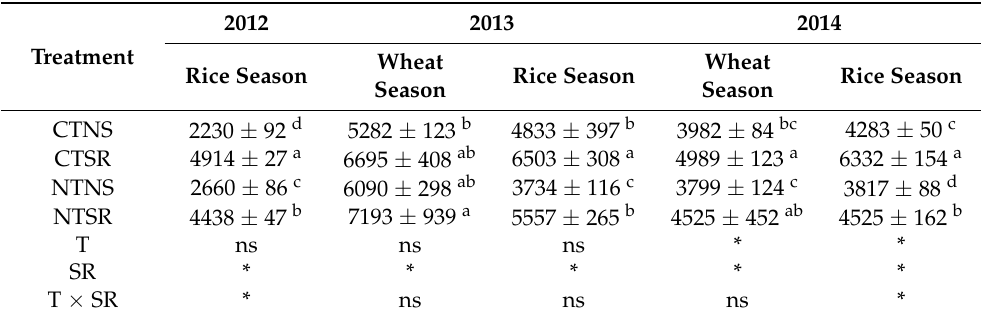
Table 3. Seasonal CO 2 emissions (kg hm − 2 ) under different tillage and straw return practices (2012– 2014) (has been published by Guo et al.